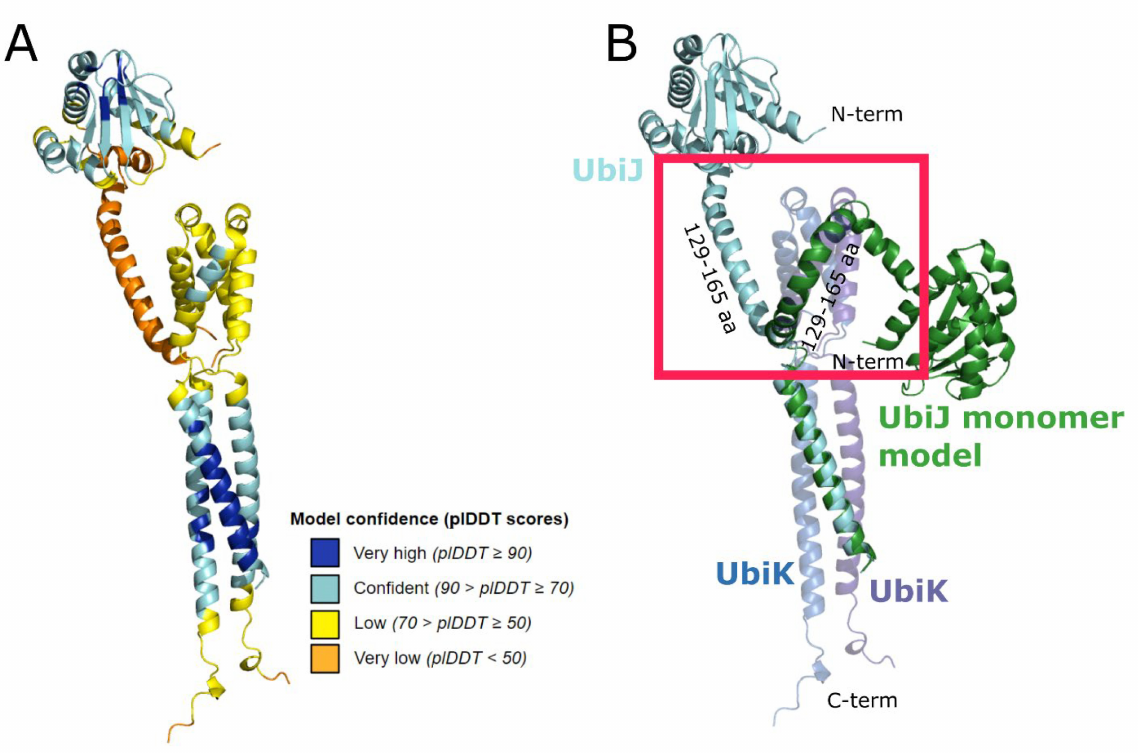
Figure 4. Modelling of the heterotrimer (UbiJ-UbiK 2 ). ( A ) Heterotrimer prediction using AF2 coloured according to the plDDT score and shown in cartoon. ( B ) Structural superimposition of the best AF2 model and the UbiJ monomer, shown in green